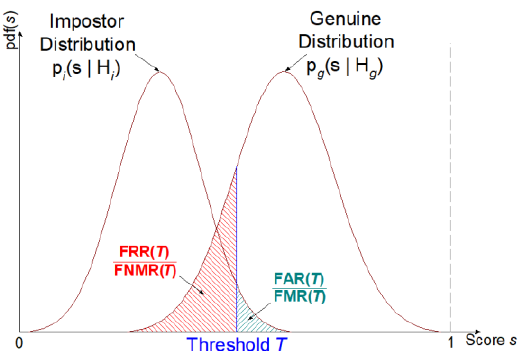
Fig. 1: Visualization of FAR/FRR metrics and their threshold relation.